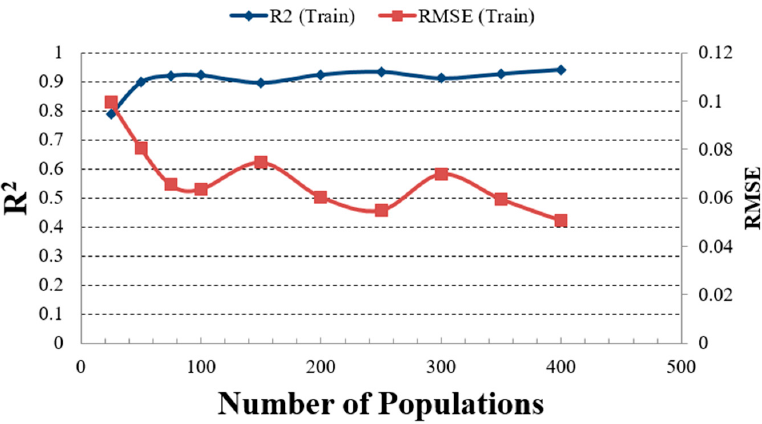
Figure 10. PIs changes for training section of GA-ANN models.